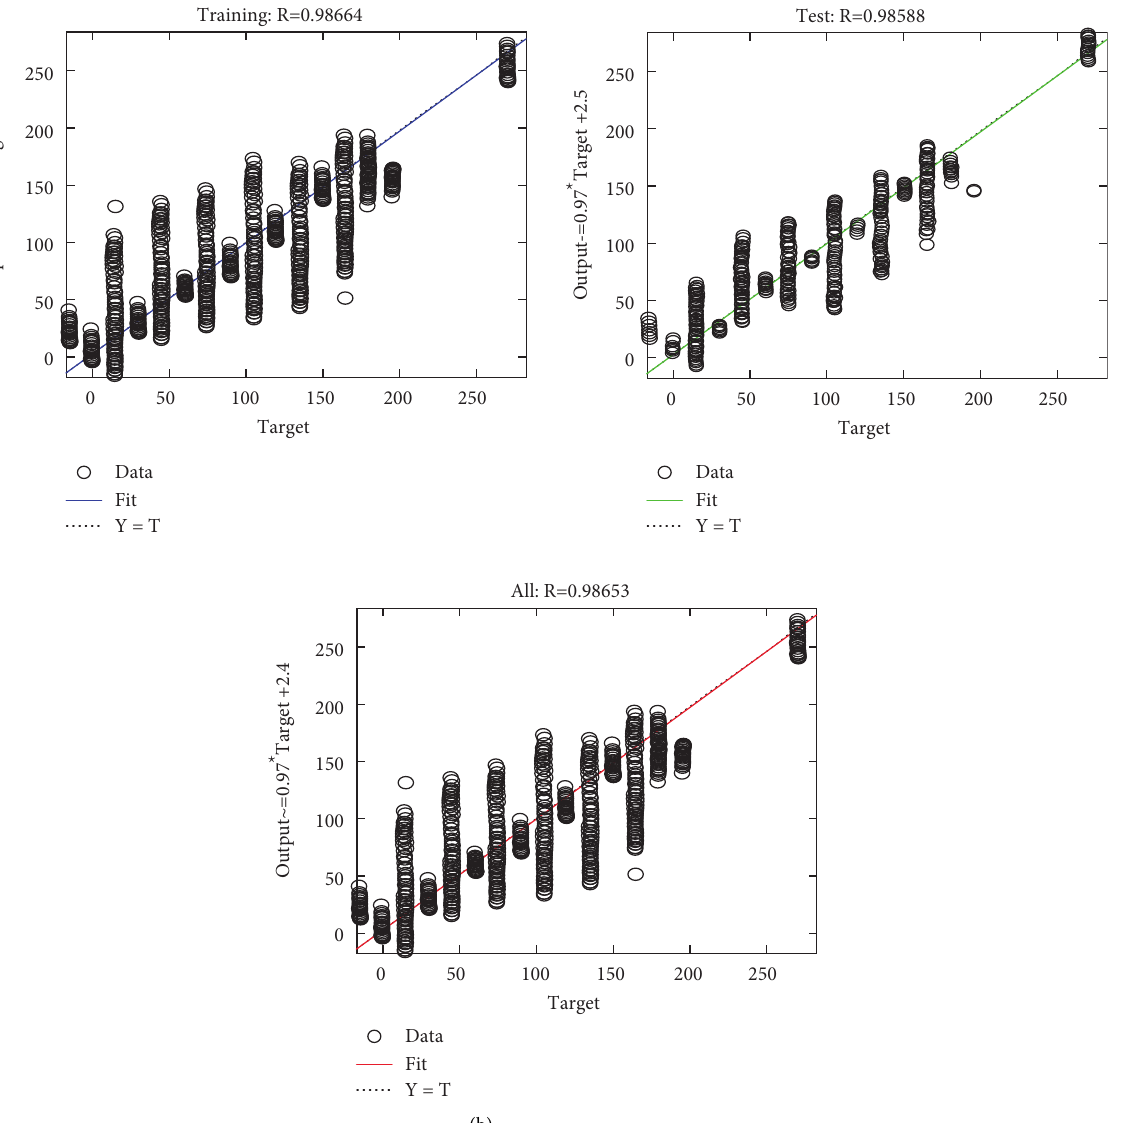
Figure 6: ANN characteristics output from backpropagation training.